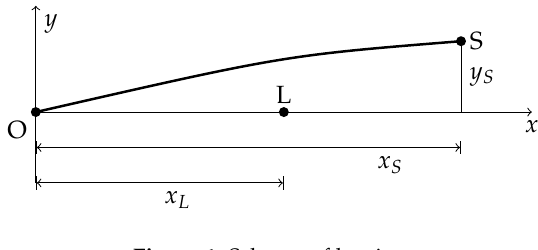
Figure 1. Scheme of